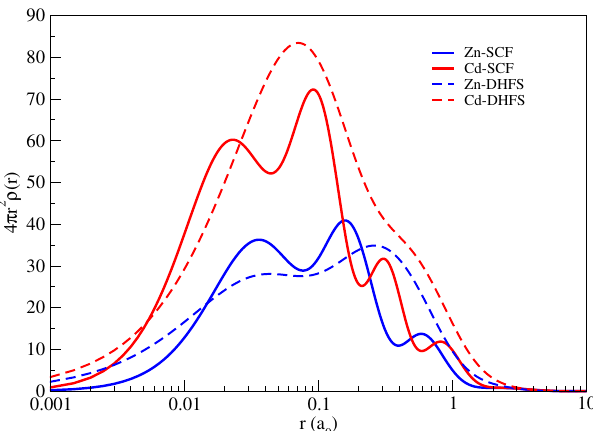
Figure 1. Radial probability density for Zn and Cd atoms obtained from Hartree–Fock (SCF) wave- functions (this work) for Zn and Cd compared to the ones calculated with model atomic charge densities obtained from the fitting of Dirac–Hartree–Fock–Slater (DHFS) calculations as given by Salvat et al. [25].